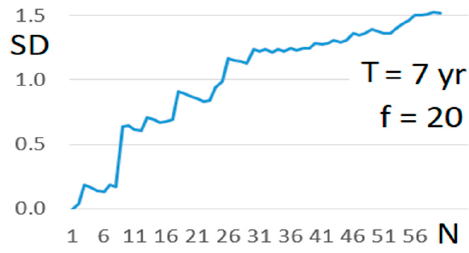
Figure 6. Consecutive standard deviations of phases for sites of amplitudes in descending order (see text). Here, as many as n = 17 sites of the highest amplitude produce SD < 0.91. The value of n is used in Figure 7.